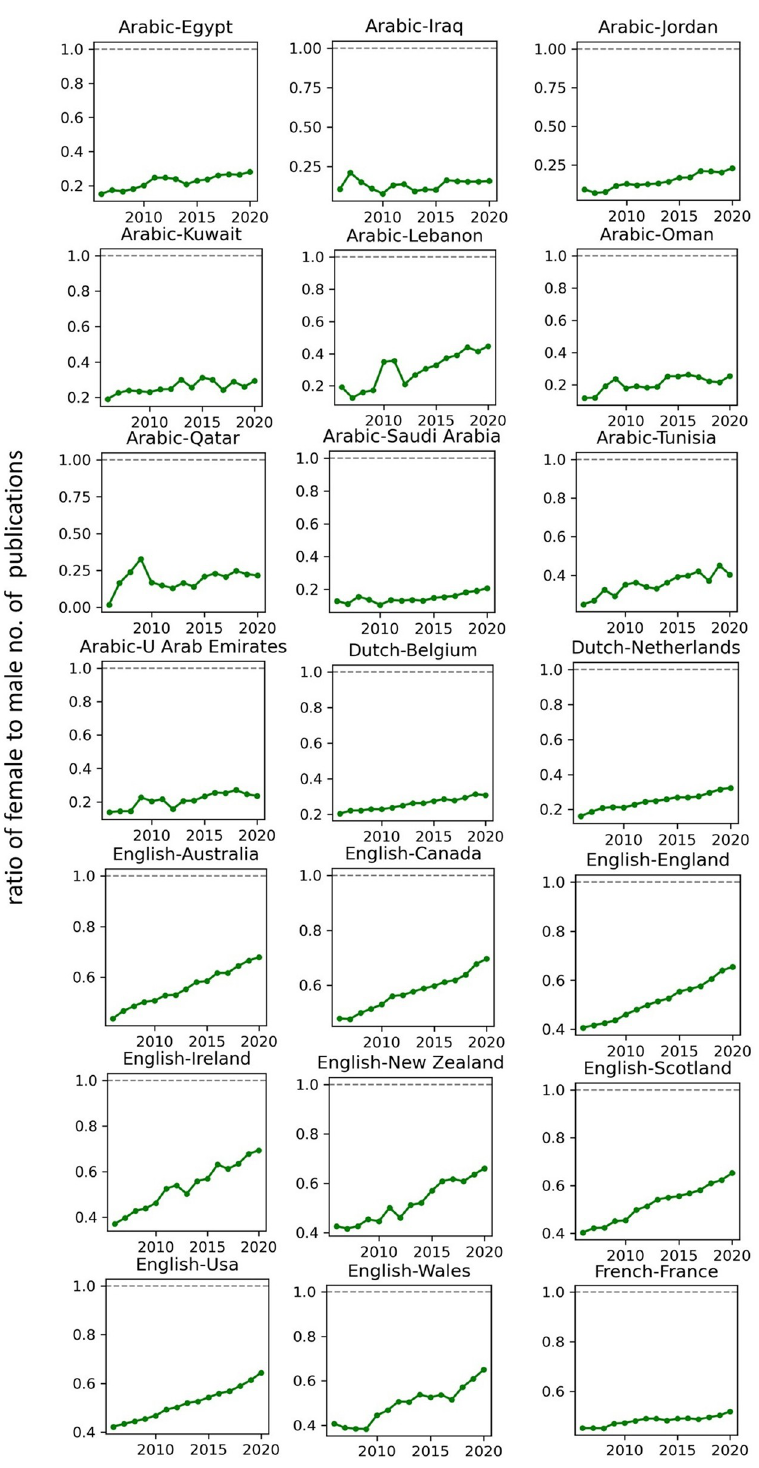
Fig 13. Ratio of female to male total research productivity, based on A-C method (part 1).